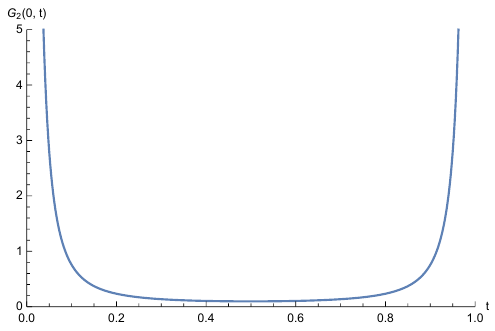
Figure 1 . The form of the correlation function G 2 (0 ; t ) for (cid:27) = 2 (cid:25)